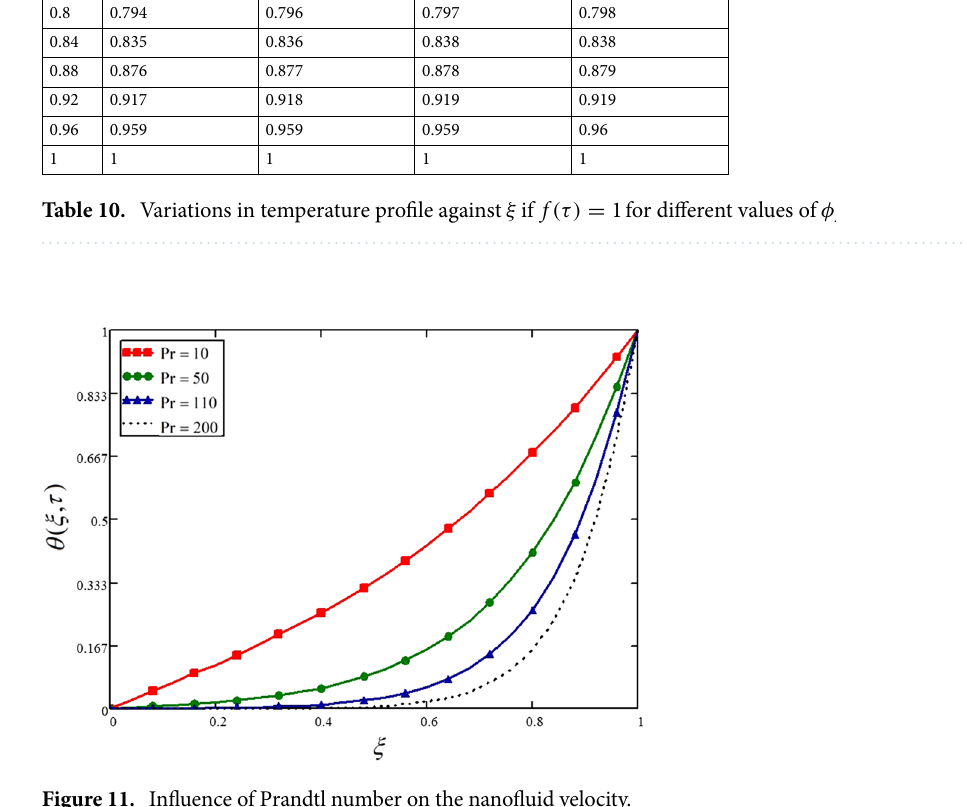
Figure 11. Influence of Prandtl number on the nanofluid